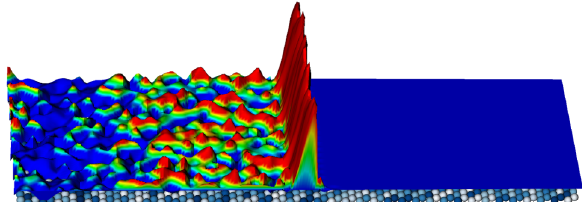
VIDEO 1. The interaction of a travelling solitary wave with the mass disorder leads to the decay in the wave amplitude. The process of energy loss is such, that it excites several smaller solitary